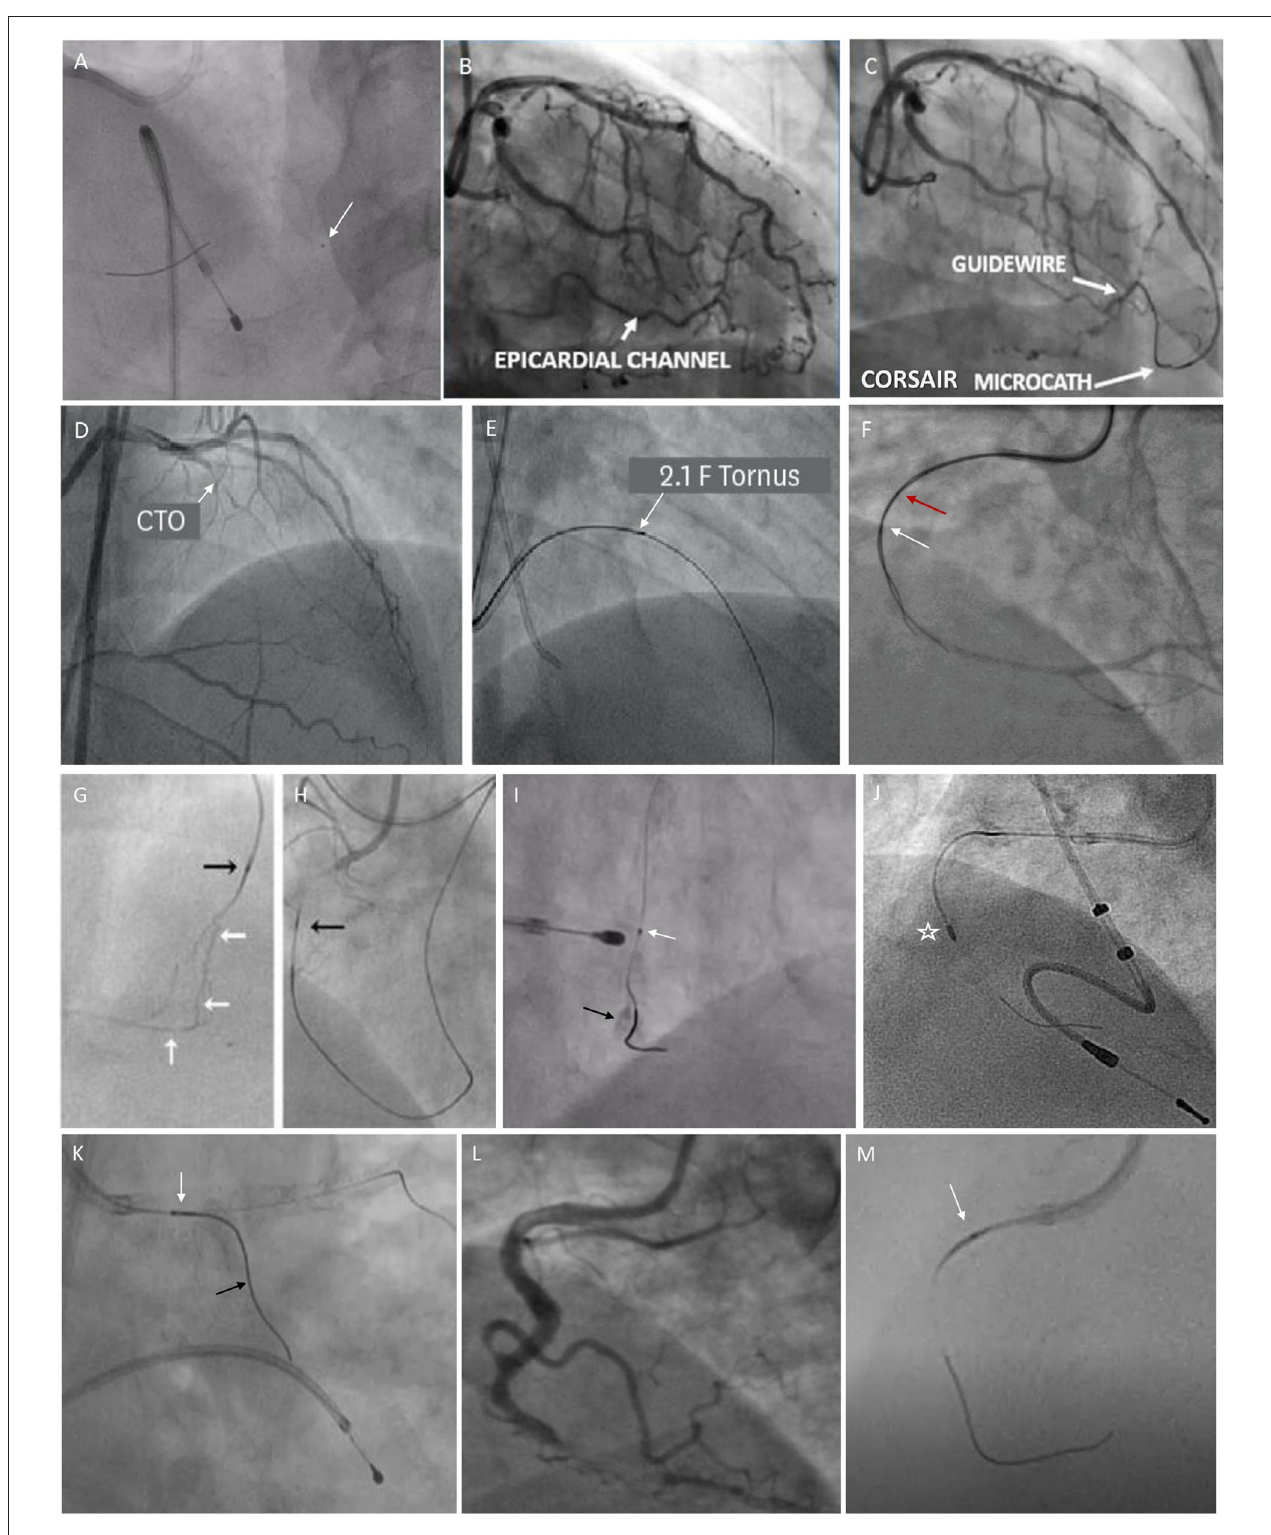
FIGURE 4 | Fluoroscopic images illustrating the usage of various microcatheters in different scenarios. (A) shows Fine Cross microcatheter in distal right coronary artery (RCA) (white arrow) being used for wire exchange. (B, C) show an epicardial collateral from left anterior descending (LAD) to distal RCA, which is traversed